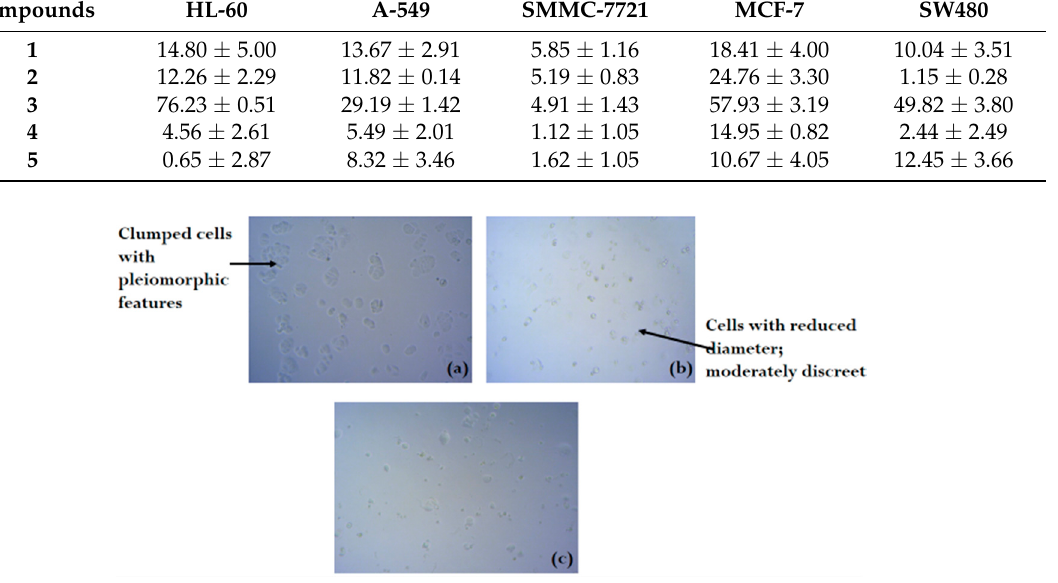
Figure 2. Photomicrograph of breast cancer cell line ( a ) untreated, ( b ) treated with cisplatin, and ( c ) treated with compound 3 (H&E x100).